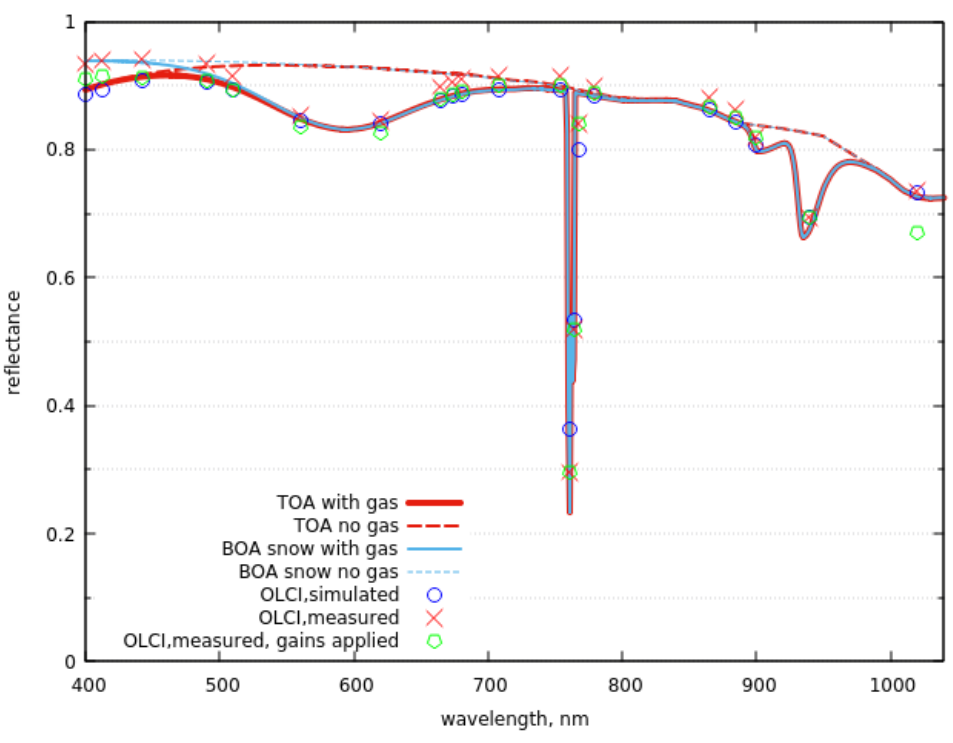
Figure 7. The spectral TOA reflectance measured by OLCI (symbols) and also modelled using Equation (2) (solid red line). Dashed red line corresponds to the artificial atmosphere without gas. Blue dashed line corresponds to the case when atmospheric contribution is neglected. Solid blue line corresponds to the case when absorption by atmospheric gases (but not light scattering in atmosphere) is fully accounted for. The solar zenith angle is equal to 63.61 degrees, the VZA is 20.63 degrees and the relative azimuthal angle is 118.39 degrees. The satellite measurements have been performed on November 10, 2017, at Dome C (Antarctica) under geometry specified above. Table 2. The parameters of the model used in Figure 7 for the case of clean snow underlying surface.